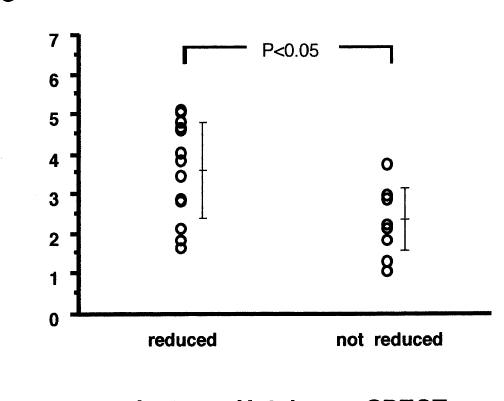
Fig. 4. The fatigue scale and the reduction of isotope uptake in the frontal lobe Patients with the reduction of isotope uptake in the frontal lobe on SPECT showed significantly higher fatigue scales. The vertical bars denote mean ± standard